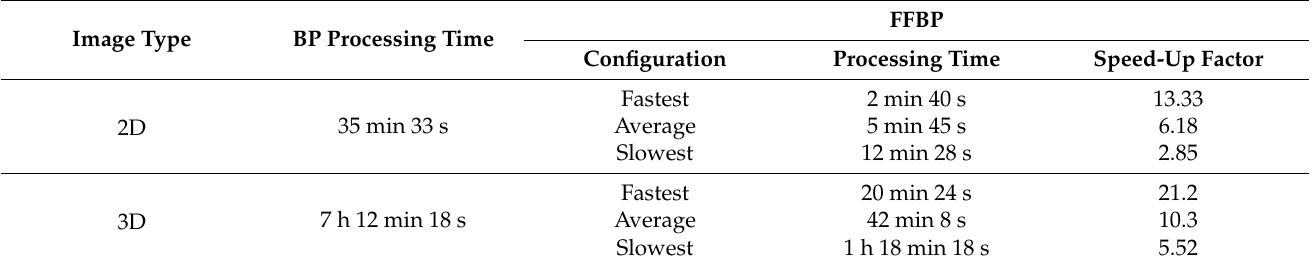
Table 5. Processing time of the slowest, fastest, and average FFBP configurations compared to the BP algorithm. Image Type BP Processing Time